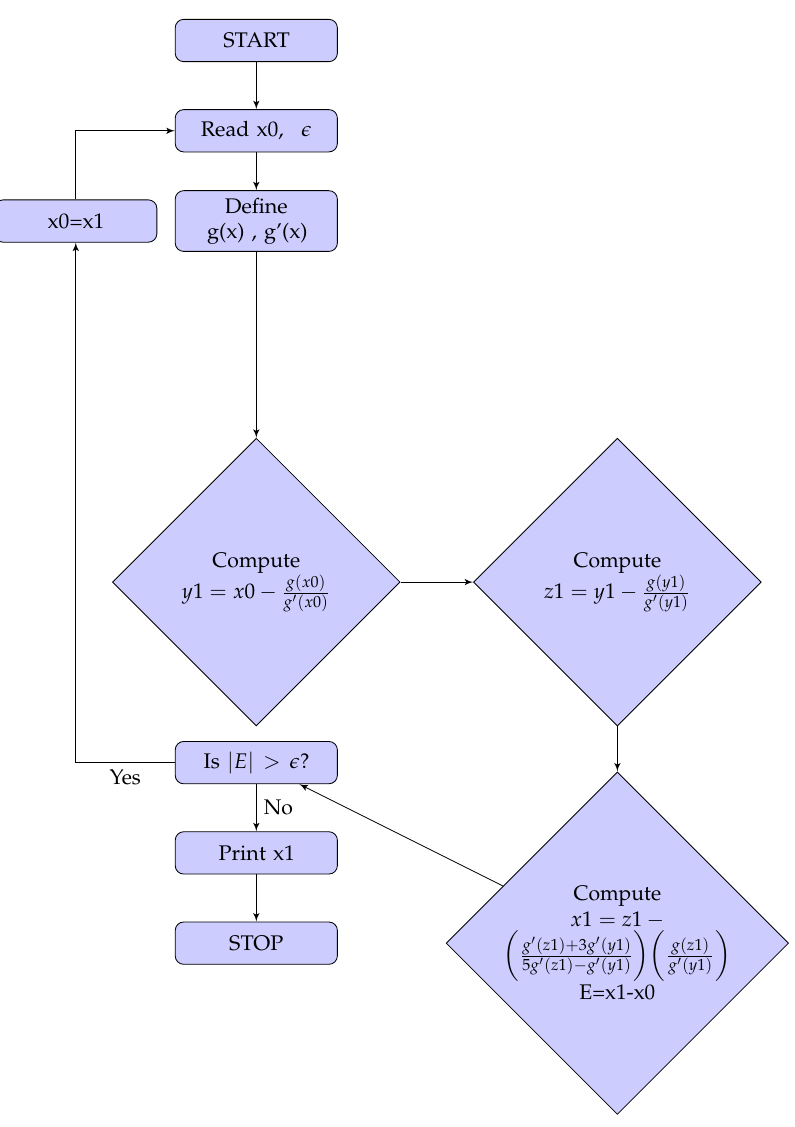
Figure 1. Flowchart of the proposed three-step method given in (8).